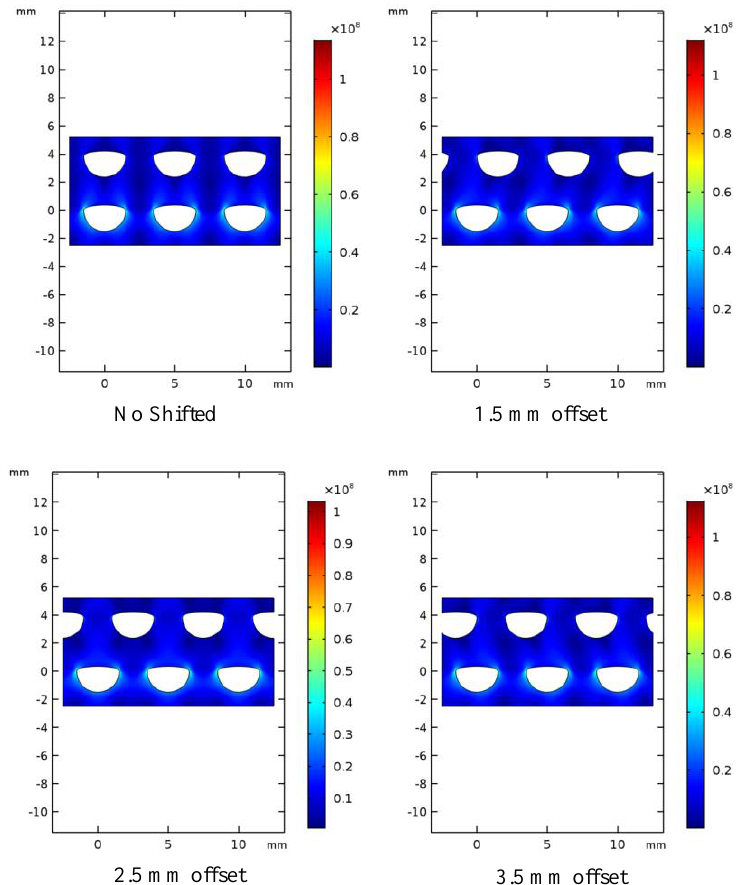
Figure 16. The von Mises stress of the four different channels offset configurations.